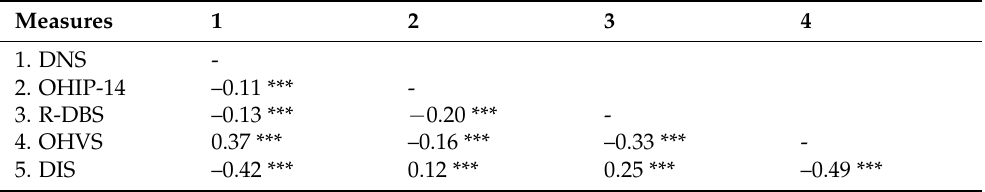
Table 3. Intercorrelations between DNS and other